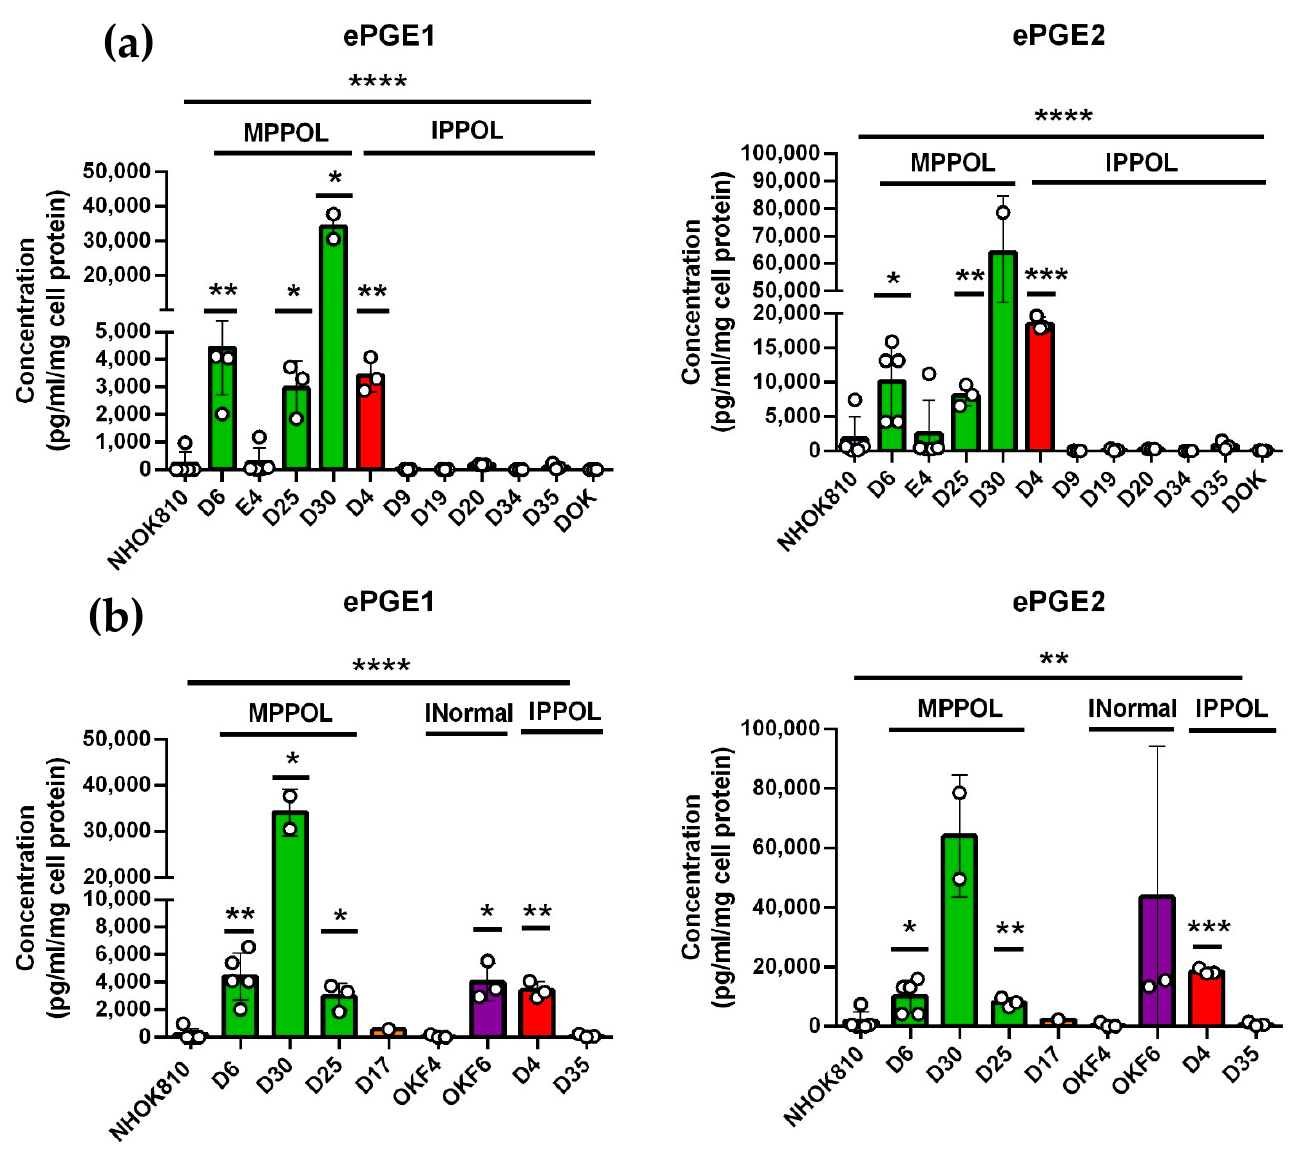
Figure 1. ( a ) The levels of ePGE1 (left panel) and ePGE2 (right panel) in normal (NHOK810 pale blue bars), a subset of the MPPOL (green bars) and IPPOL (red bars) keratinocytes. ( b ) NHOK810 (pale blue bars) compared with the p16 INK4A − / − MPPOL line D17 (orange bar) at early passage and the normal keratinocyte lines were immortalized with defined genetic elements OKF4 and OKF6 (purple bars) assayed with NHOK810 separately. The data are expressed as the level of ePGE in ng/mL/mg cell protein and was derived from 3 independent experiments ( n = 3) ± standard deviation assayed in duplicate except for NHOK810 ( n = 5); D6 ( n = 5); D30 ( n = 2); D17 ( n = 1). * p < 0.05; ** p < 0.01; *** p < 0.001; **** p < 0.0001 when compared to the normal keratinocyte line NHOK810. Line over the graphs is an analysis of the data sets by one-way ANOVA. MPPOL = mortal PPOL lines; IPPOL = immortal PPOL lines; INormal normal oral keratinocytes immortalized by defined genetic elements and/or TERT .